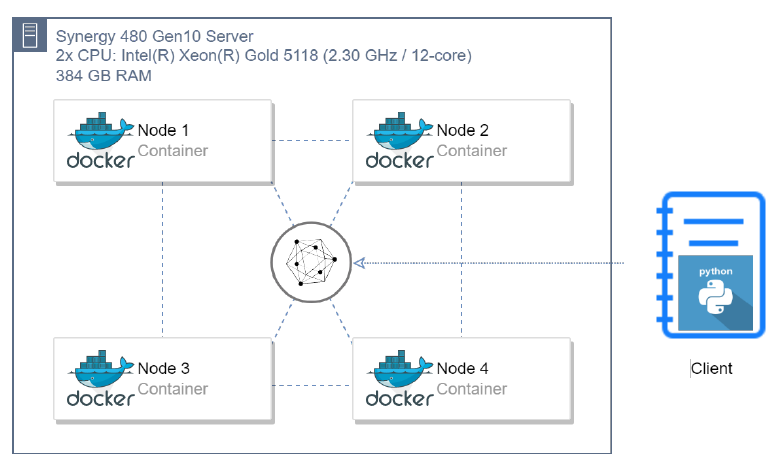
Figure 3. Evaluation architecture in a private